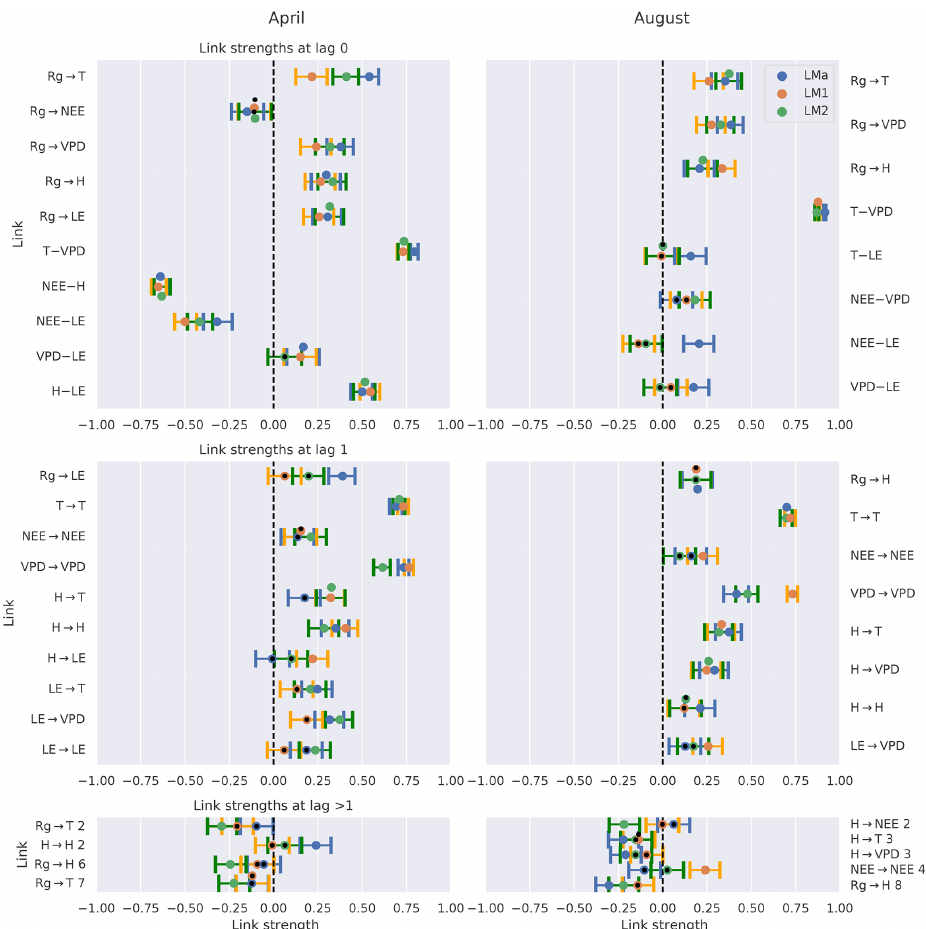
Figure 4. Comparison of the networks of three eddy covariance measurement stations (LMa, LM1, LM2) located in Majadas de Tiètar (Spain). Links that are found to be significant in one of the three networks are included. For each link, the calculated strength of all three networks is plotted with its 90% confidence interval. The colours blue, orange, and green correspond to the towers LMa, LM1, and LM2, respectively. The significance threshold is 0.01. If a link does not pass the significance, it is marked by a black dot. The links are grouped into lag 0 (top), lag 1 (middle), and all lags greater than 1 (bottom). Negative NEE is associated with carbon uptake by the ecosystem. Links at lag 0 are left undirected (–), yet as R g is set as main driver, links incorporating R g at lag 0 are directed ( →